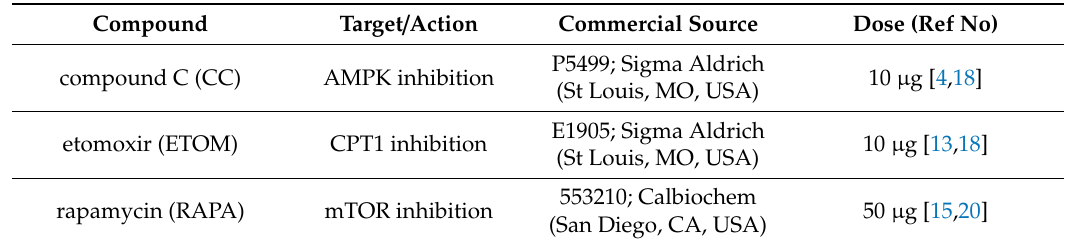
Table 1. Summary of the compounds used in the present study and detailed information about their actions, dosage and reference for dose